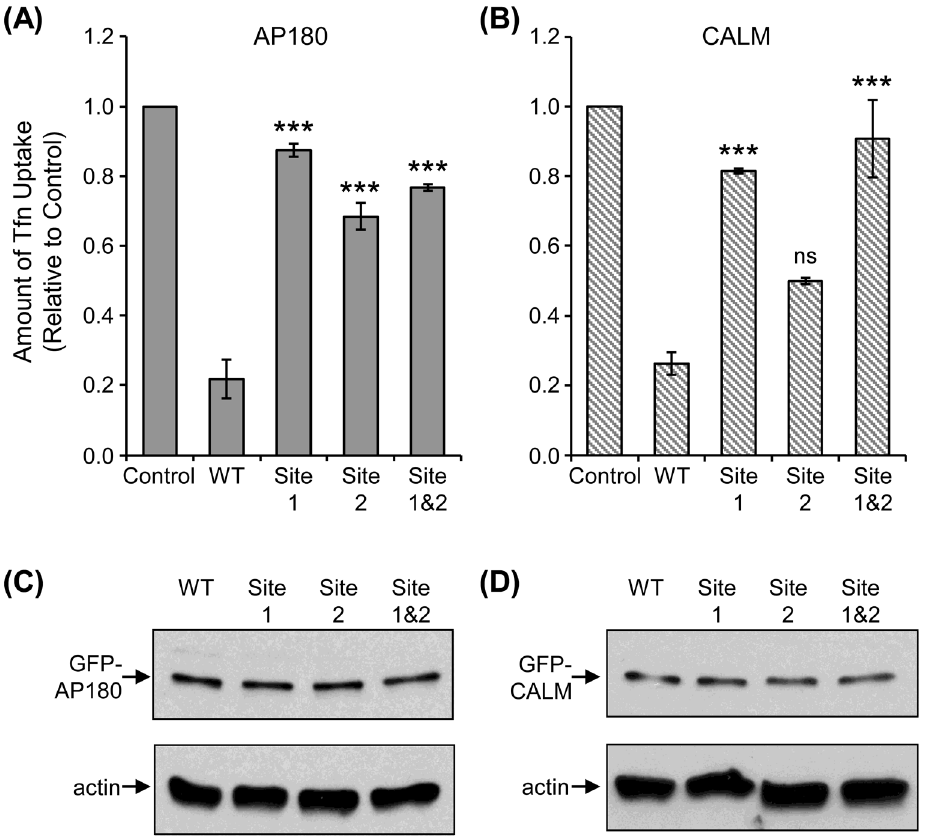
Fig 5. Comparison of WT, Site 1 and Site 2 mutated AP180 and CALM in a transferrin uptake assay. COS-7 cells were transfected with GFP-tagged WT, Site 1, Site 2 and Site 1&2 mutants for (A) AP180 and (B ) CALM. Alexa Fluor 594 labelled Tfn (red) was added and the amount of uptake was measured as an assay of endocytosis function and clathrin sequestration. Note that in (A) and (B), respectively, GFP-tagged WT AP180 and CALM exhibit a dominant negative effect due to sequestration of clathrin. Data is expressed as a fraction of Tfn uptake in untransfected control cells ± SEM ( n = 4; *** , P < 0.001 compared to WT; ns = not significant). The approximately equal expression level of AP180 and CALM fusions with GFP is shown in panels (C) and (D) , respectively, which was produced from COS-7 cell lysis, SDS-PAGE and Western blotting with anti-GFP or anti-actin (control for protein